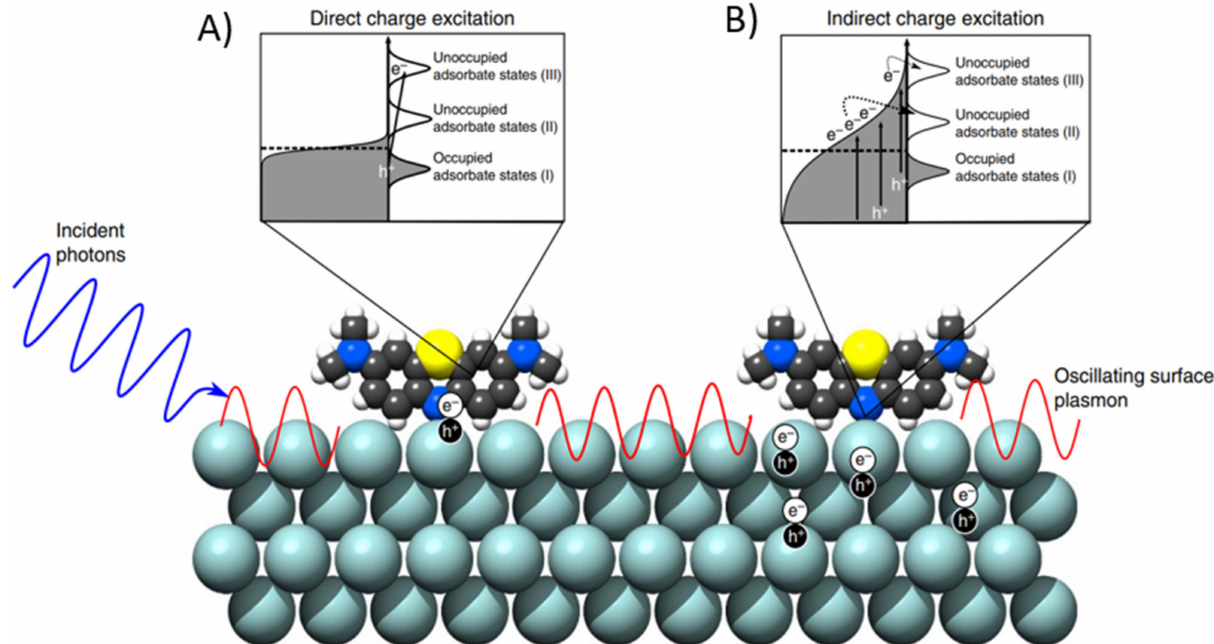
Figure 5. As a result of the plasmon decay, the formation of charge carriers can produce a direct or an indirect charge transfer. ( A ) The direct transfer allows the excited electron to directly occupy an empty higher energy level. ( B ) Indirect transfer requires the formation of an electronic distribution, then an excited electron can be transferred into an absorbate orbital. Adapted with permission from Boerigter et al. Nat. Commun. 2016, 7, 10545, Copyright 2016, SpringerNature